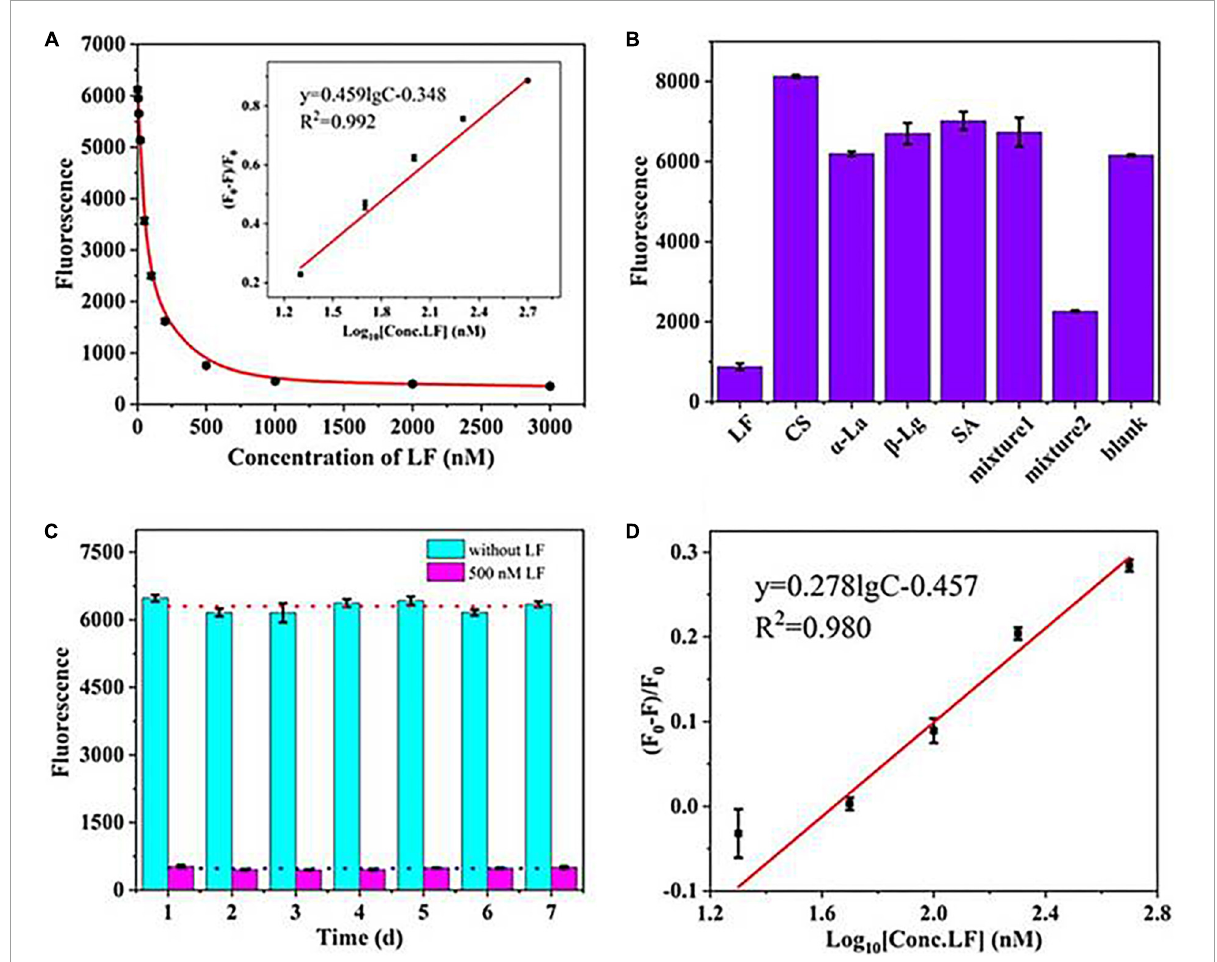
FIGURE2 (A) The linear relationship between (F 0 –F)/F 0 and the concentrations of LF. (B) The specificity of the aptasensor strategy. (C) Stability assessment of the fluorescence aptasensors. (D) The calibration curve in milk powder